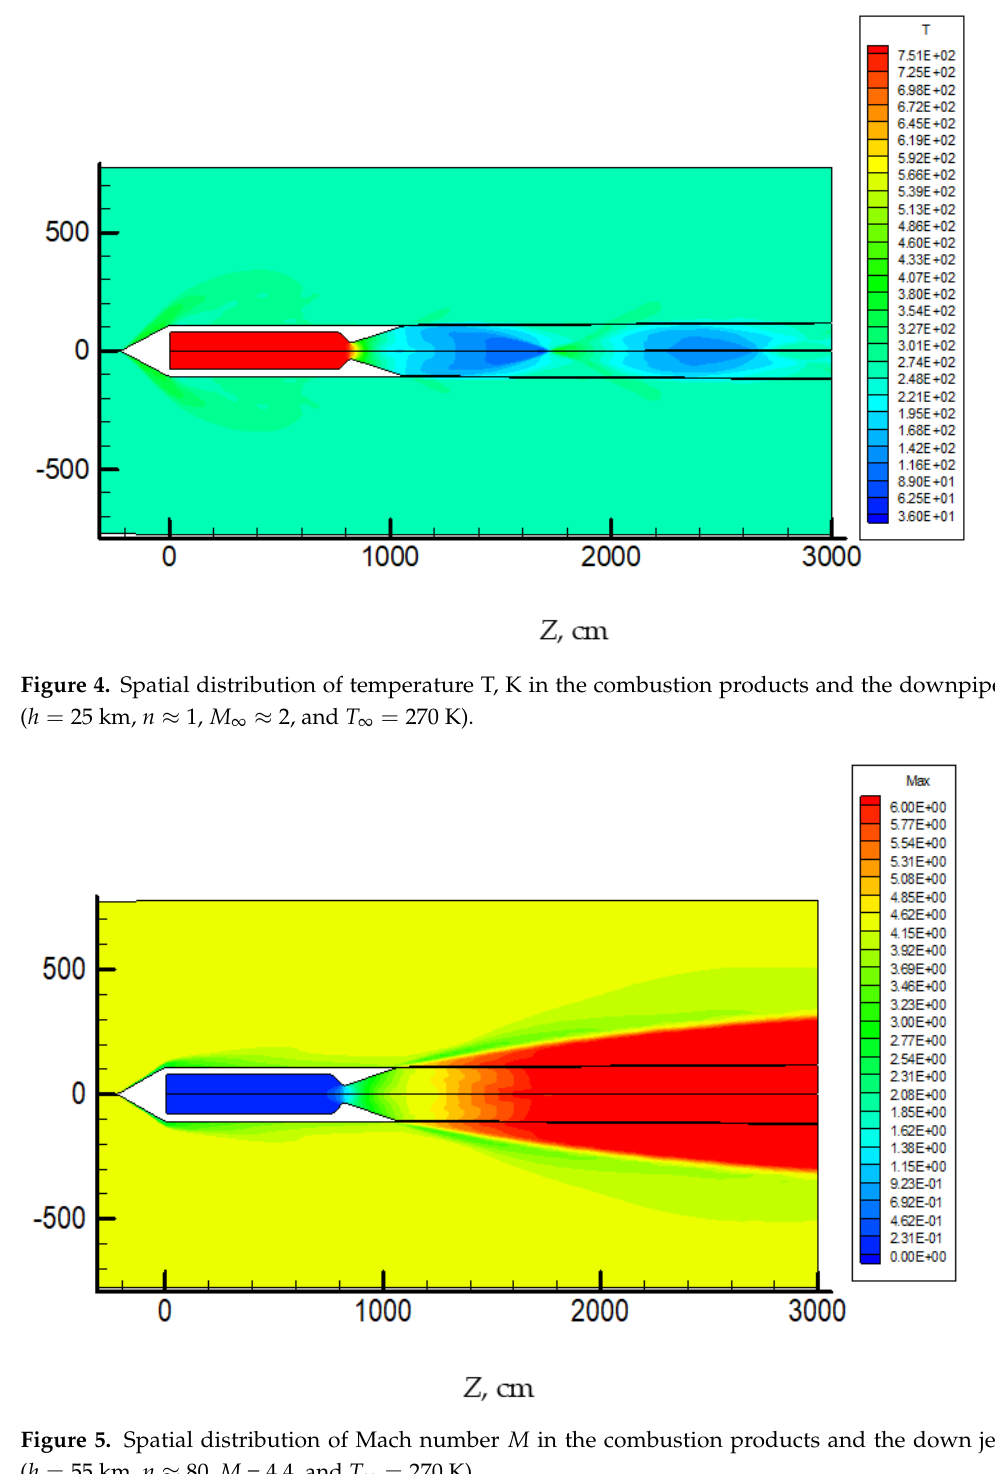
M in the combustion products and the down jet